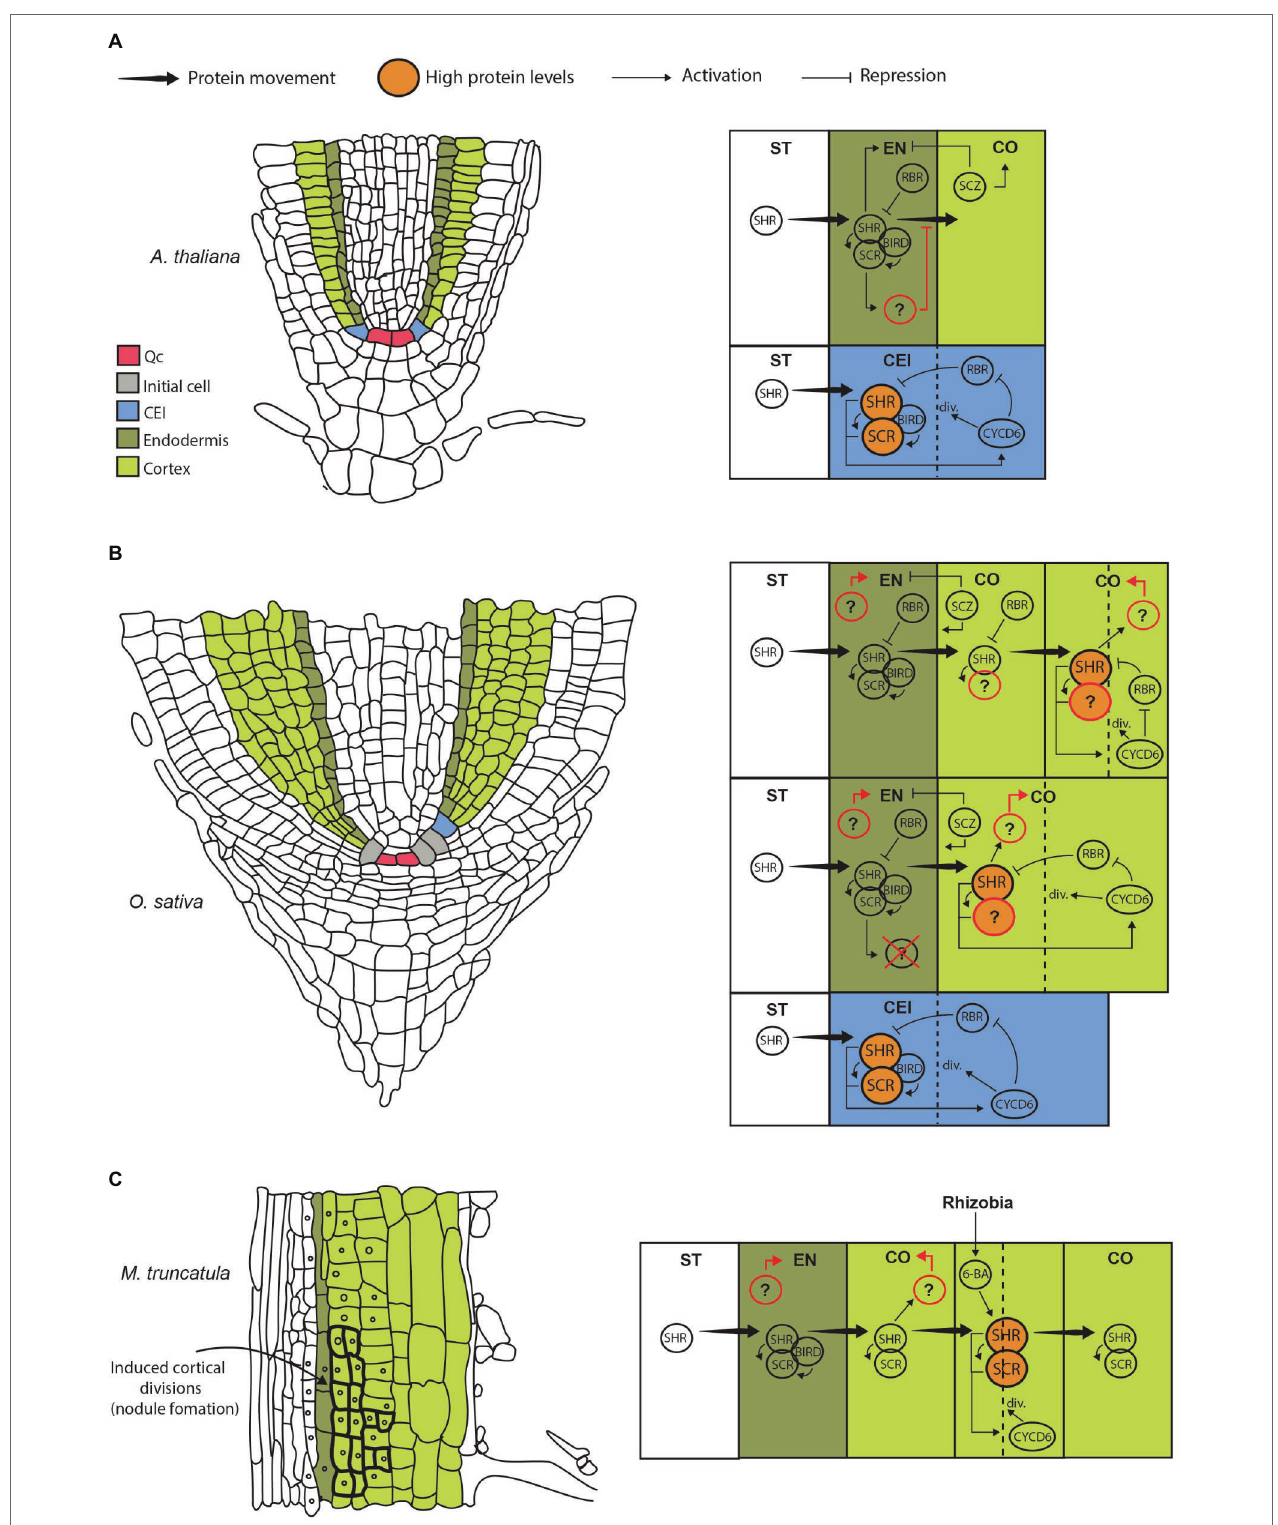
FIGURE 1 | Genetic models for GT formation and cortex expansion in different species. (A) Cartoon showing a longitudinal section from an Arabidopsis thaliana root highlighting initial and GT cells (left). Diagram representing the CEI, endodermis, cortex and stele, where the main genetic pathways contributing to GT formation are depicted (right). Briefly, SHR protein moves from the stele into the CEI where it induces SCR expression. SHR and SCR form a complex that moves